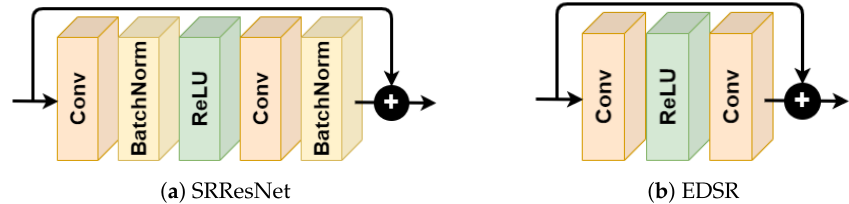
Figure 1. Architecture of ResBlocks in SRResNet and Enhanced Deep Residual Networks